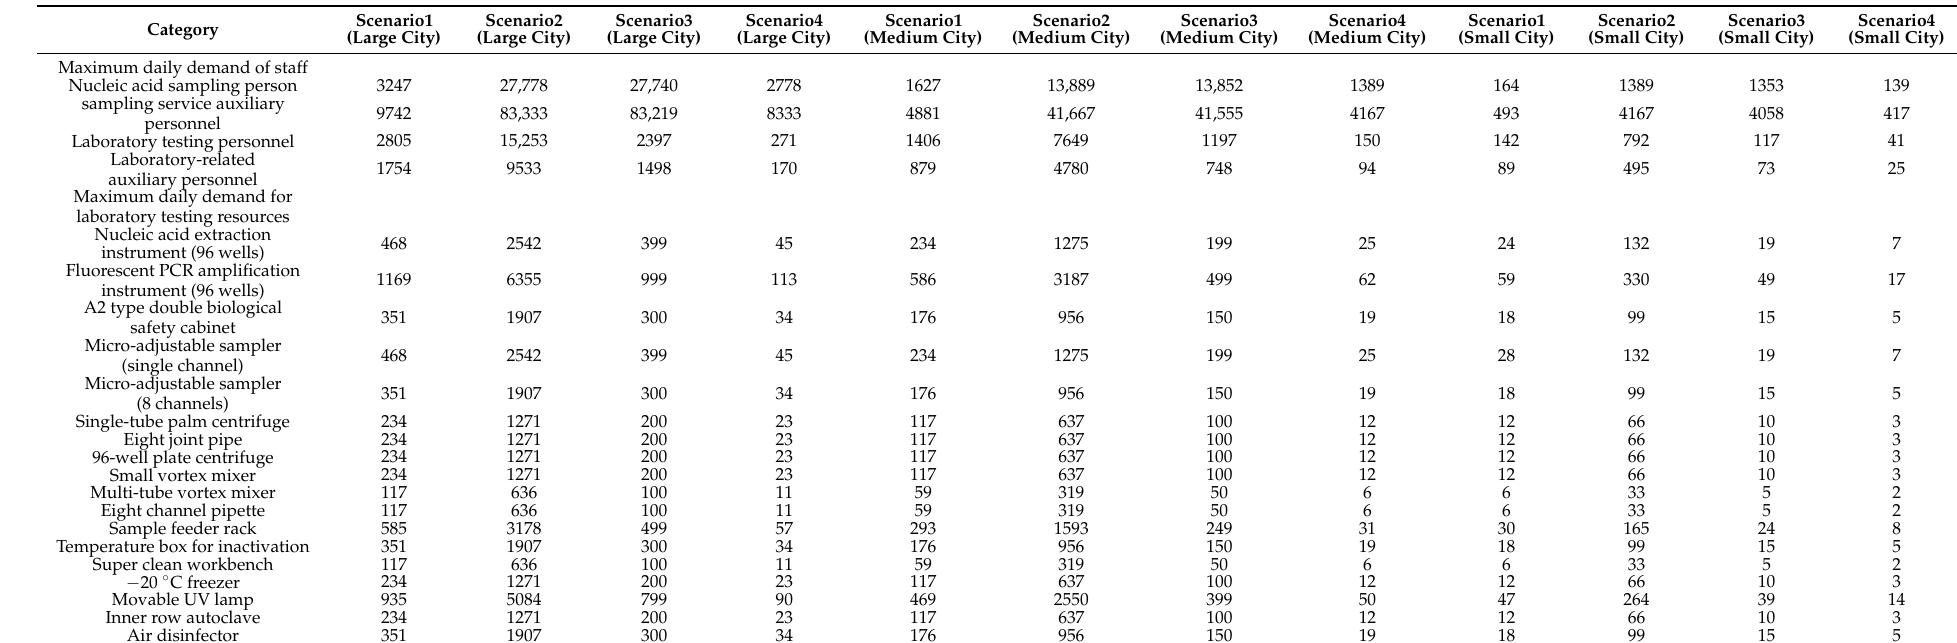
Table 3. Maximum daily demands of various resources under different scale city scenarios